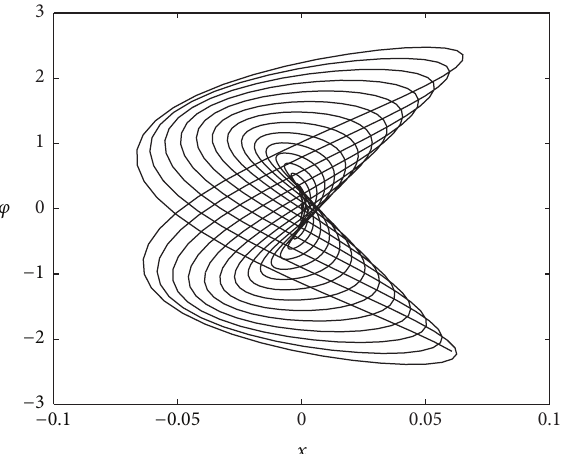
Figure 10: Diagram illustrating the variation of 𝑥 via 𝜑 when 𝜔 2 = 0.1 [rad ⋅ s −1 ], 𝜎 1 = −0.005 [rad ⋅ s −1 ], and 𝜎 2 = −0.005 [rad ⋅ s −1 ].